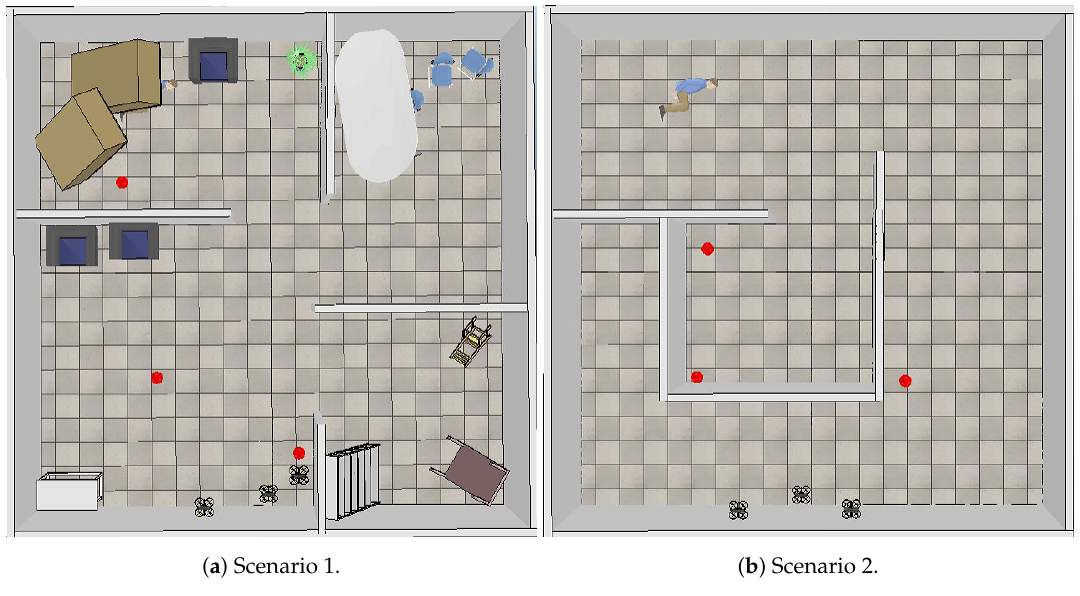
Figure 8. V-REP simulation scenarios.